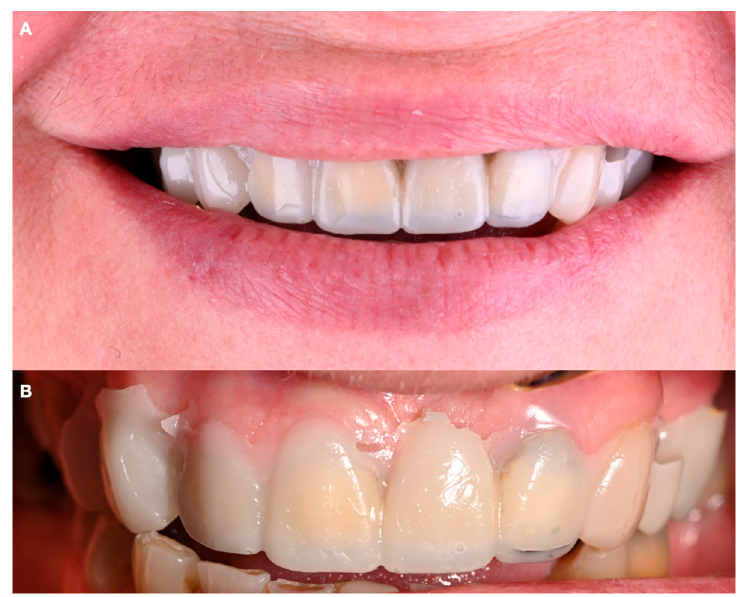
Figure 5. Intraoral mock-up. ( A ) External smile view. ( B ) Internal view.